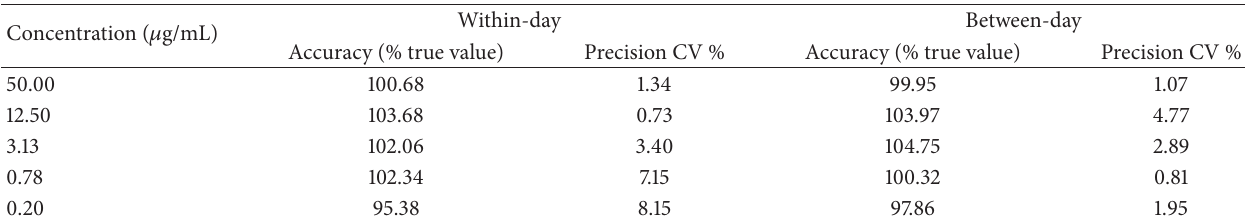
Table 1: Within-day and between-day precision and accuracy values for lycorine obtained from HPLC-UV analysis. Concentration ( 𝜇 g/mL)